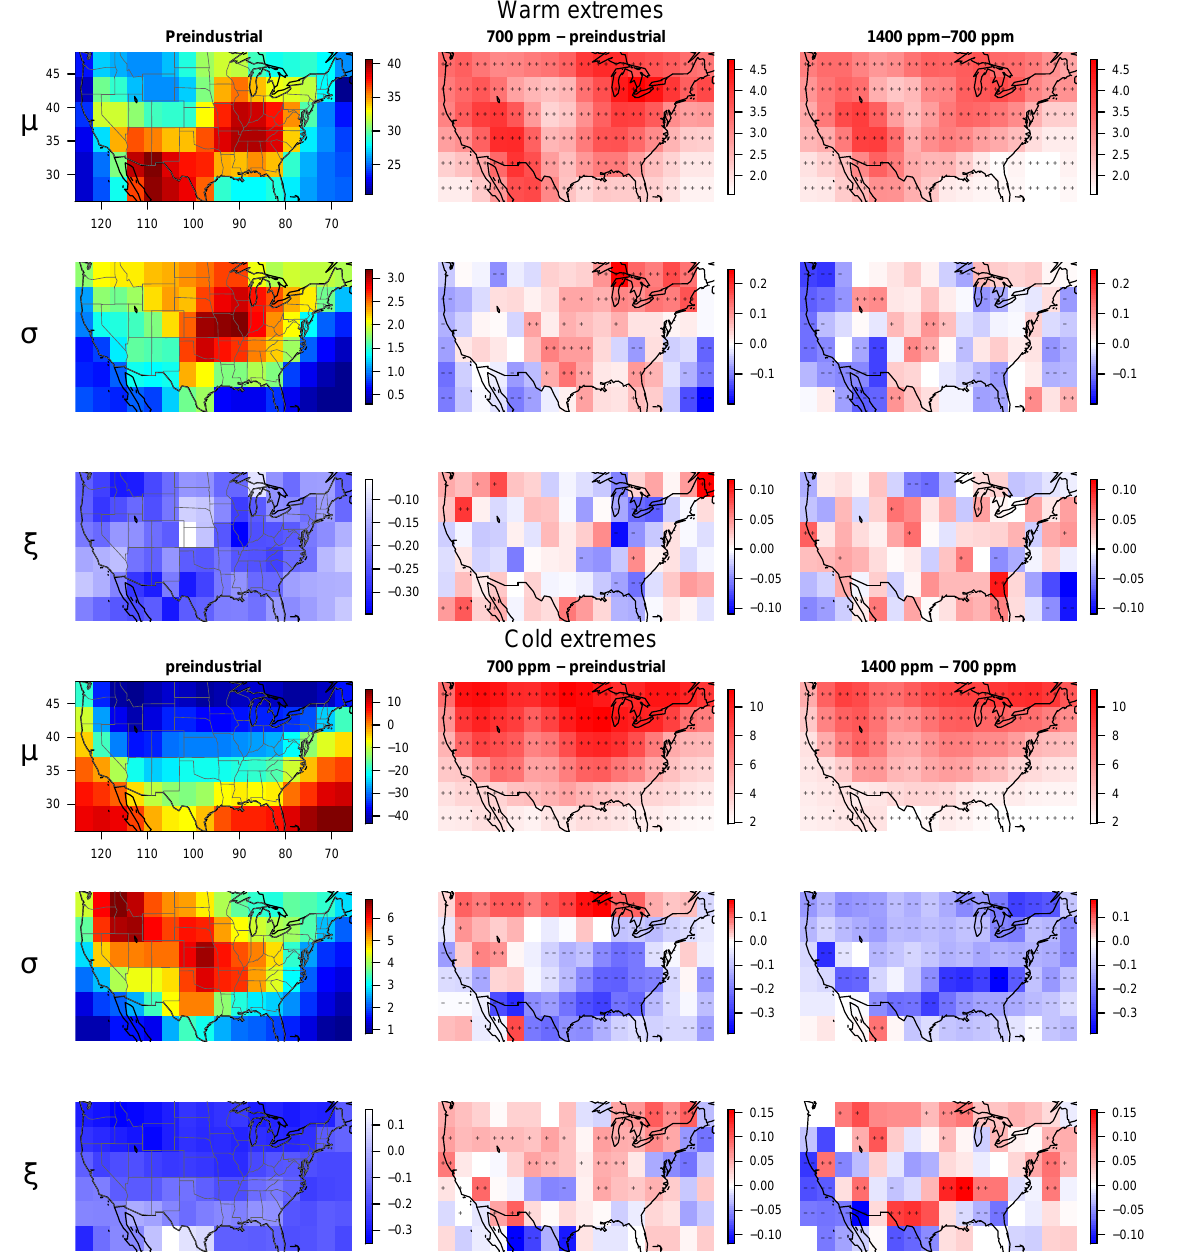
Figure 4. The estimated CCSM3 GEV parameters and their changes in possible future climate conditions. Left: fitted GEV parameters (location µ , scale σ , and shape ξ ) for annual extremes for the baseline model run at pre-industrial CO 2 concentration. The top three panels are for warm extremes and the bottom ones are for cold extremes. Negative ξ is expected for temperature distributions. Middle: changes in parameters ( (cid:49)µ,(cid:49) log σ,(cid:49)ξ ) after a warming of global mean temperature by 3.4 ◦ C (by raising atmospheric CO 2 to 700ppm). Right: changes in parameters after an additional 2.7 ◦ C warming (by raising CO 2 from 700 to 1400ppm). The symbols ++ or −− mean the bootstrapped p value for testing whether the parameter is different in the scenarios is < 0 . 02; + or − mean the p value is between 0 . 02 and 0 .